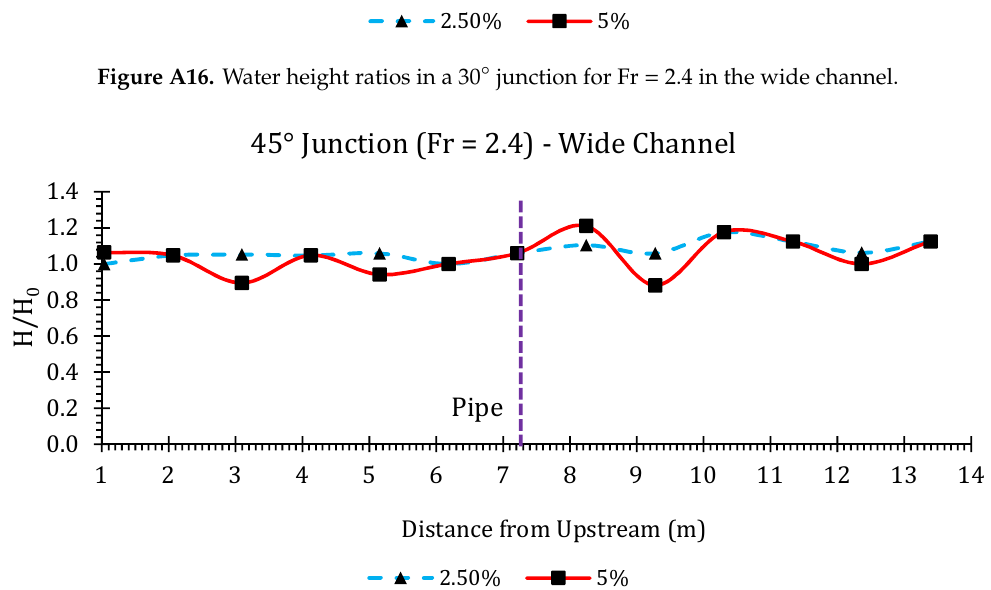
Figure A17. Water height ratios in a 45 ◦ junction for Fr = 2.4 in the wide Figure A17. Water height ratios in a 45° junction for Fr = 2.4 in the wide channel. Figure A17. Water height ratios in a 45° junction for Fr = 2.4 in the wide channel. Figure A17. Water height ratios in a 45° junction for Fr = 2.4 in the wide channel.